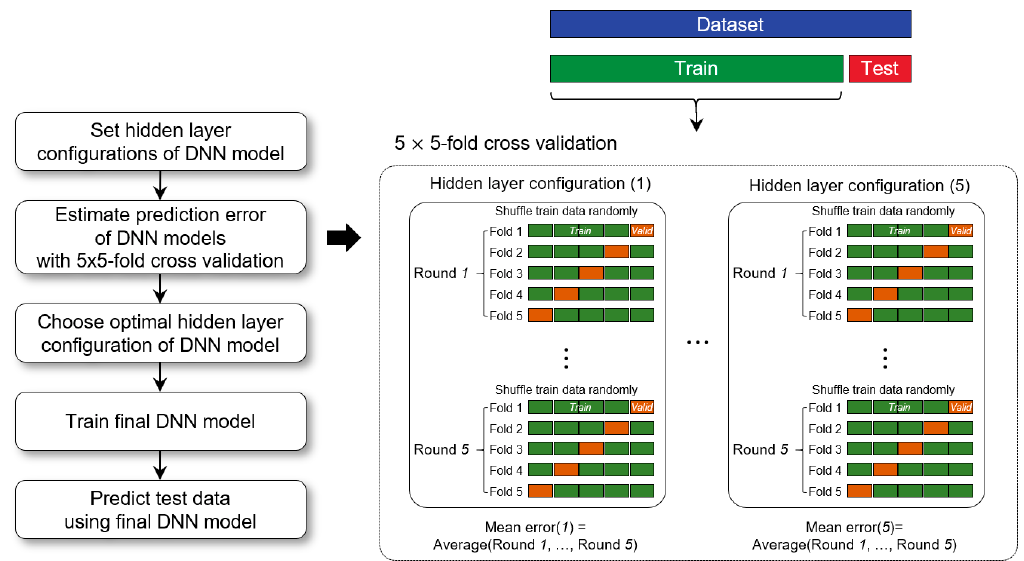
Figure 8. Process of optimizing DNN model configuration.